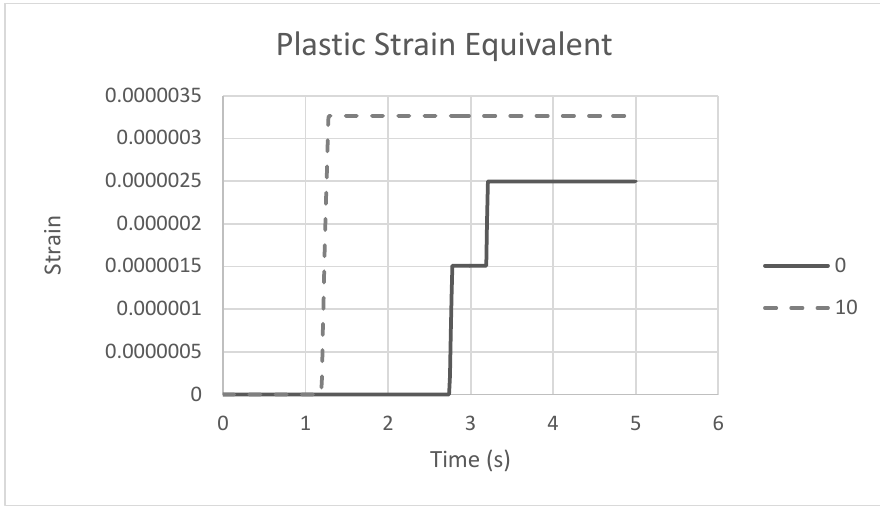
Fig. 16. The equivalent plastic strain at the joint node.